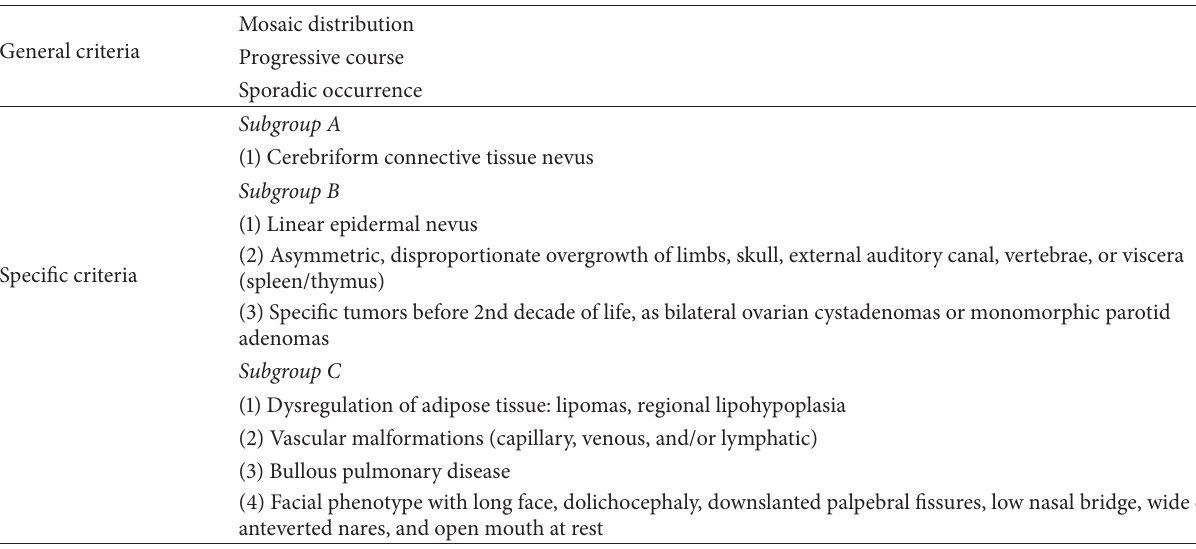
Table 1: Revised Proteus syndrome diagnostic criteria [4].